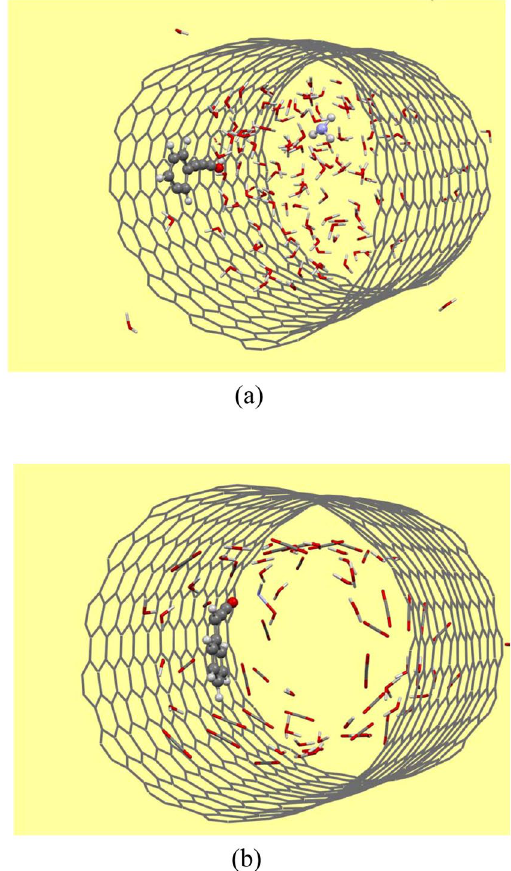
Figure 3. Systems containing the phenylalanine and ( a ) pure water and ( b ) binary mixture of water and 55% CO 2 within the C-passive (15, 15) CNT at 200